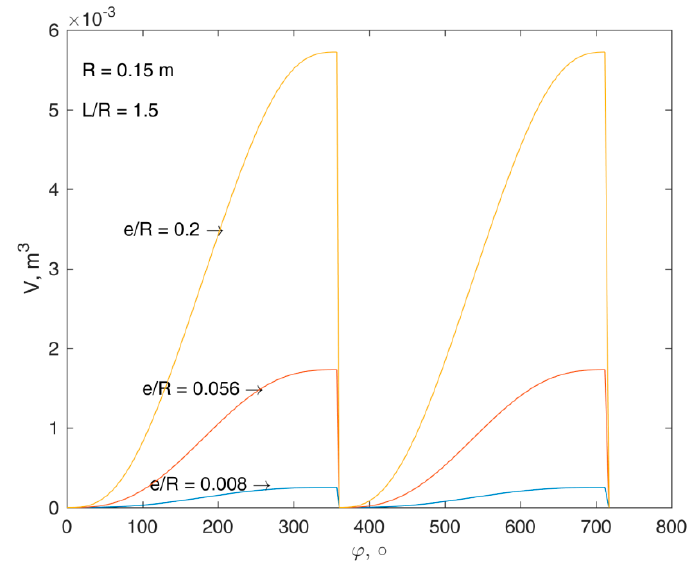
Figure 7. Working chamber volume versus rotor rotation angle for different eccentricities ( e ).